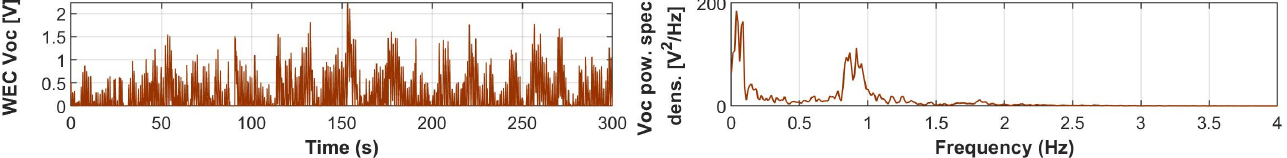
Figure 10. Experimental results of the first test at the sea. ( Left ) time series of the WEC’s open circuit output voltage ( V OC ) in V. ( Right ) power spectral density of V OC